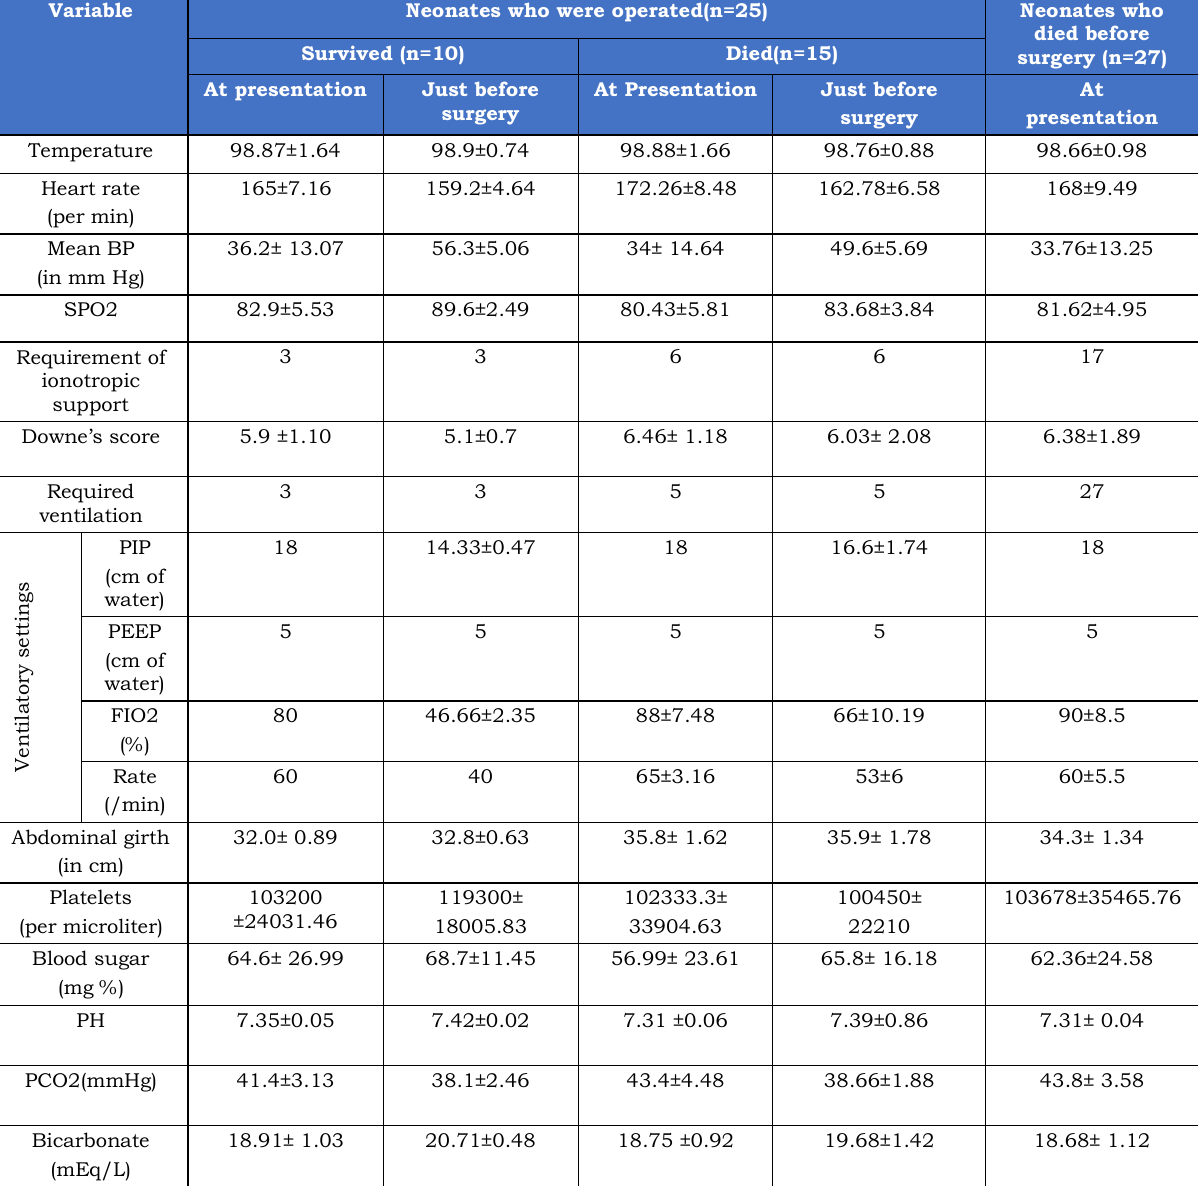
Table 4: Follow-up of Patients